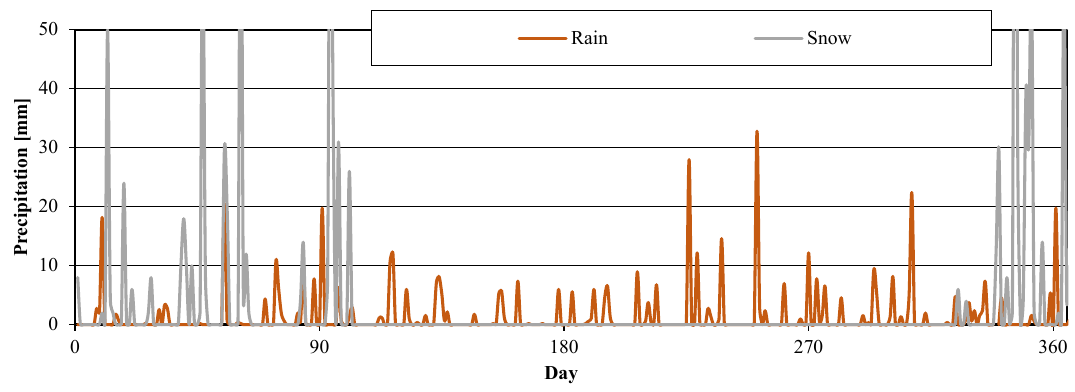
Figure 4. Outdoor ambient air temperature and wind speed condition.